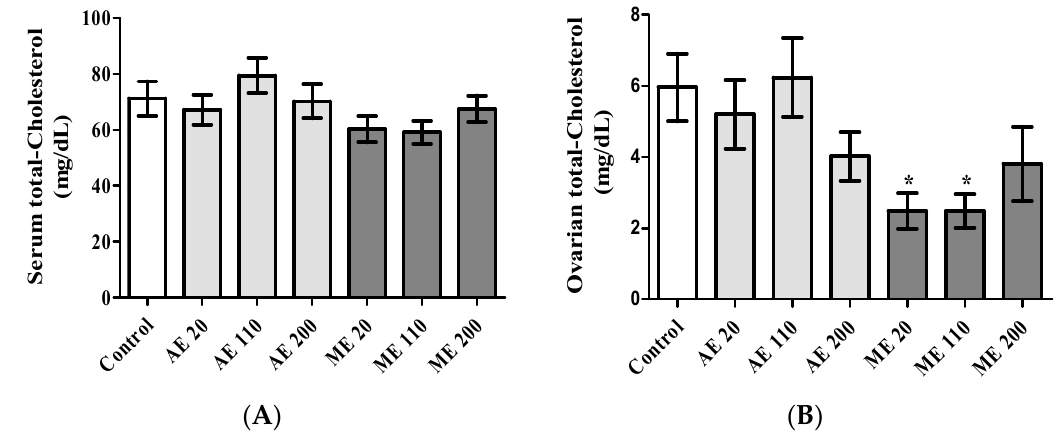
Figure 5. Serum ( A ) and ovarian ( B ) total cholesterol levels following treatments. Control = Animals receiving vehicle (distilled water, 10 mL/kg BW); AE = animals treated with the aqueous extract of M. arboreus ; ME = animals treated with the methanol extract of M. arboreus . Results are shown as the mean ± SEM; *: p < 0.05 in reference to control.